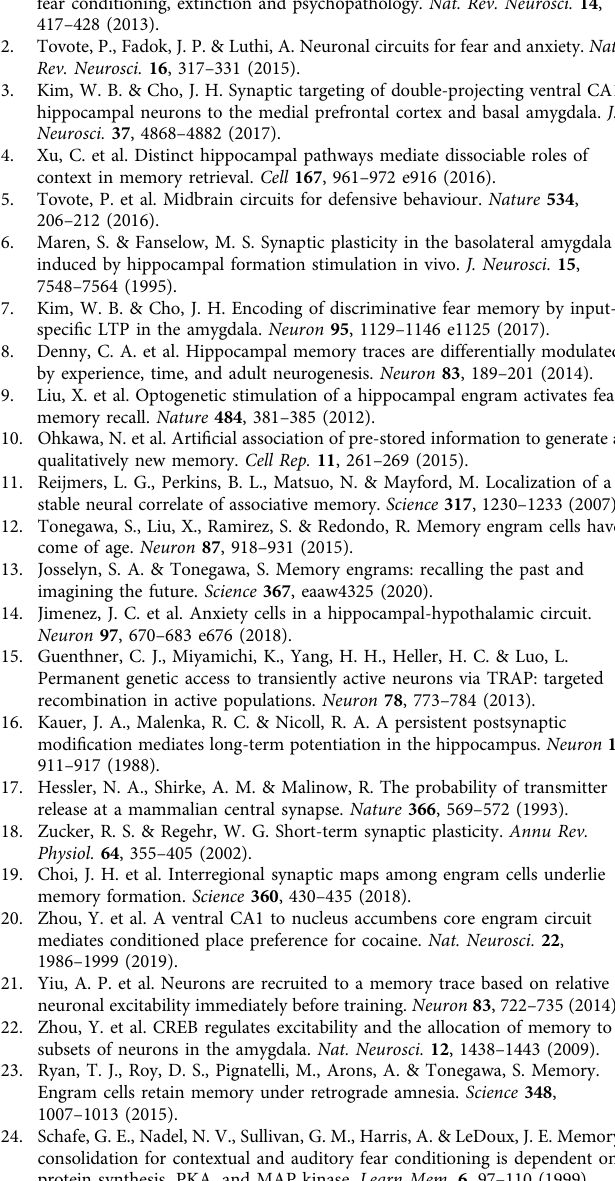
Reproducibility . Micrographic images presented in fi gures are representative ones from experiments repeated independently: Fig. 1b (10 times), 1d (18 times), 1f